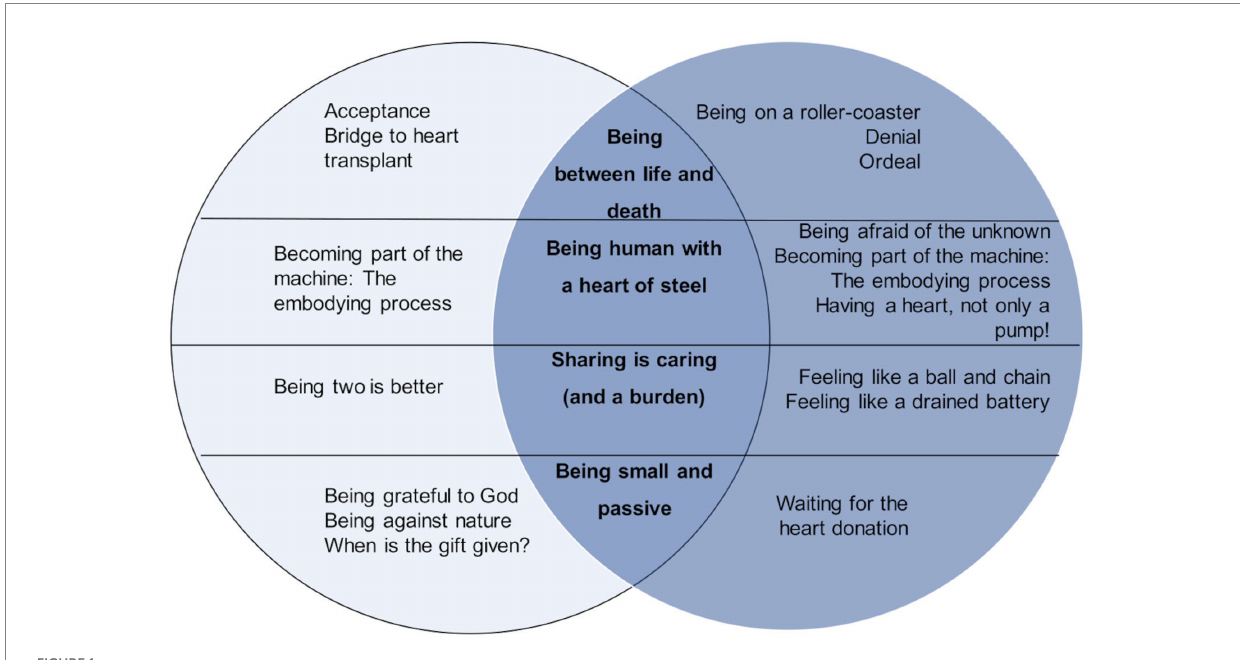
FIGURE 1 The LVAD experience of patients and their